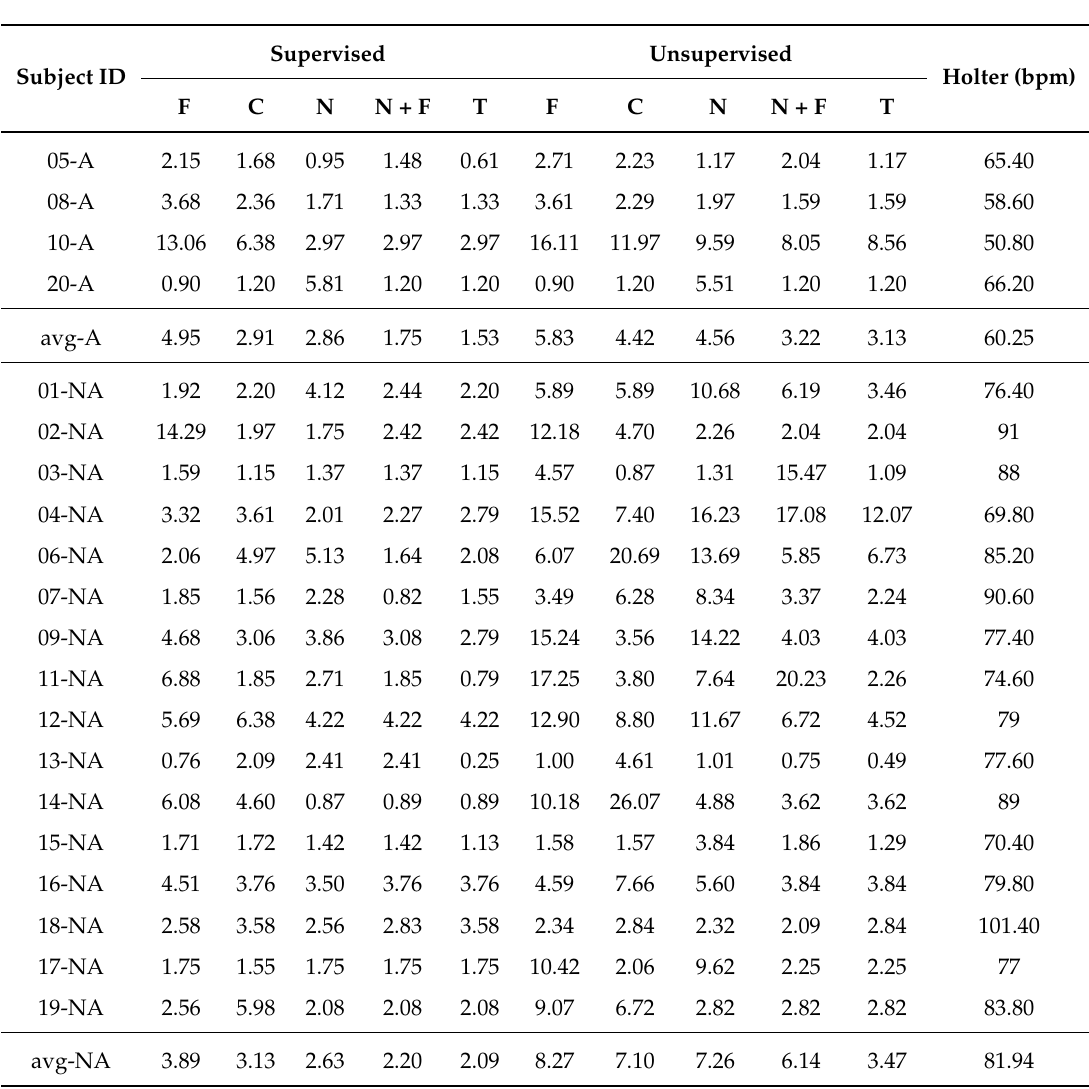
Table 3. Average error (%) in HR estimation for each subject with RGB data from the Kinect and Holter average values, with the supervised and unsupervised approach. The subjects are grouped considering their lifestyle as Athletes (A) and Noon-Athletes